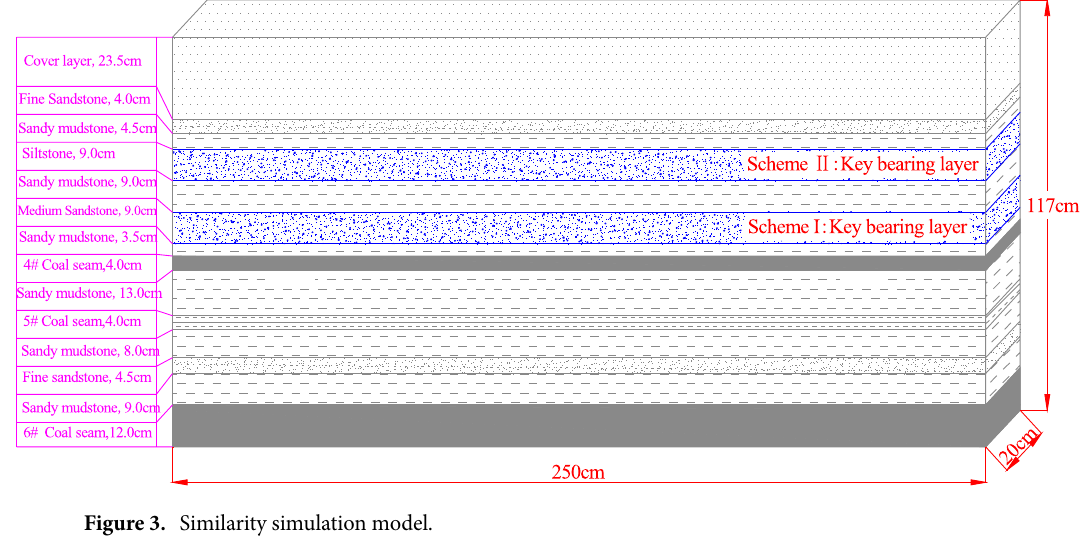
Figure 3. Similarity simulation model.